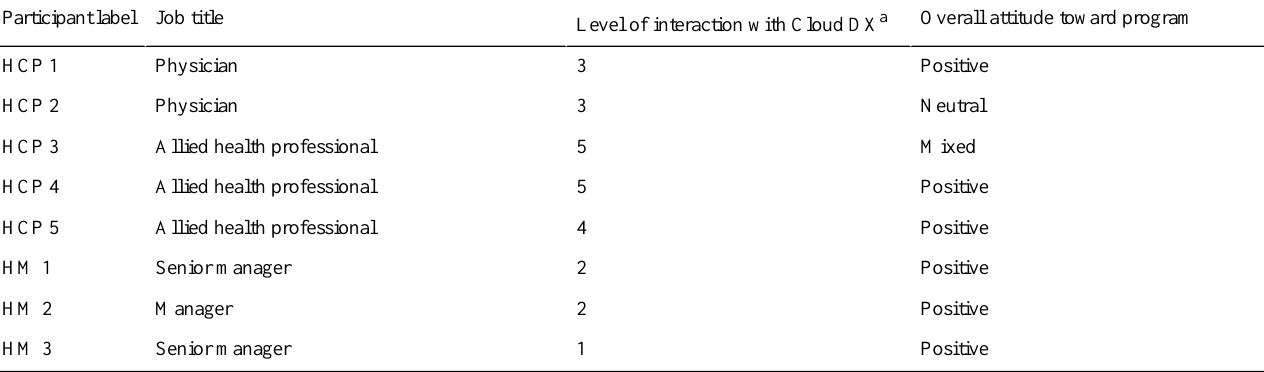
Table 3. Overview of the health care providers and hospital managers who